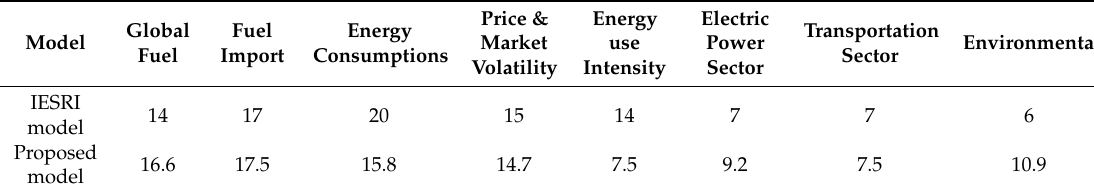
Table 21. IESRI vs proposed weight